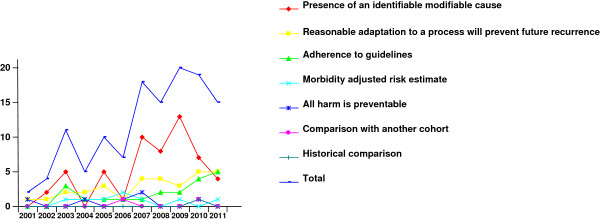
Year of publication.